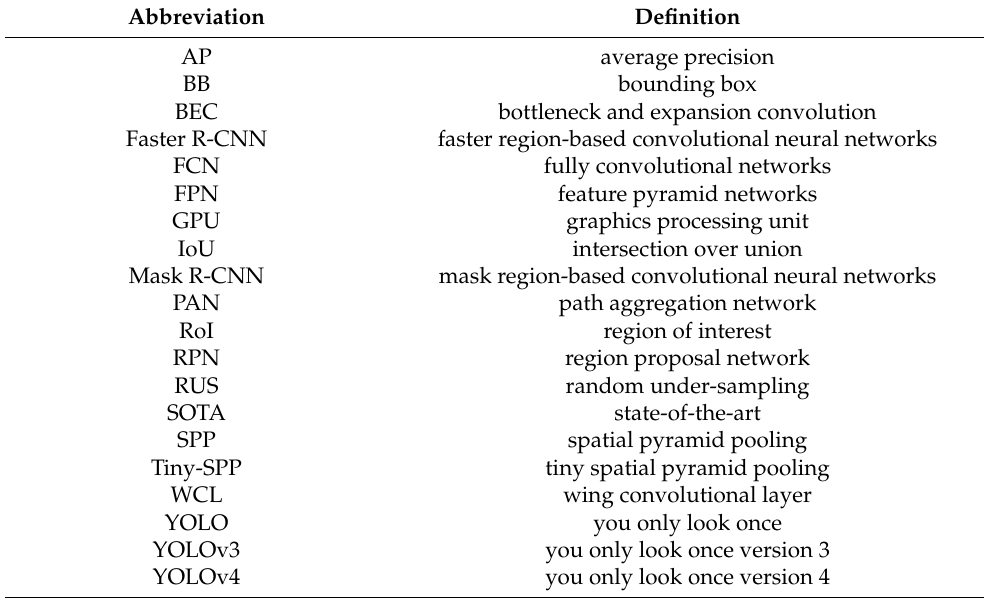
Table 1. List of abbreviations and acronyms used in the paper.